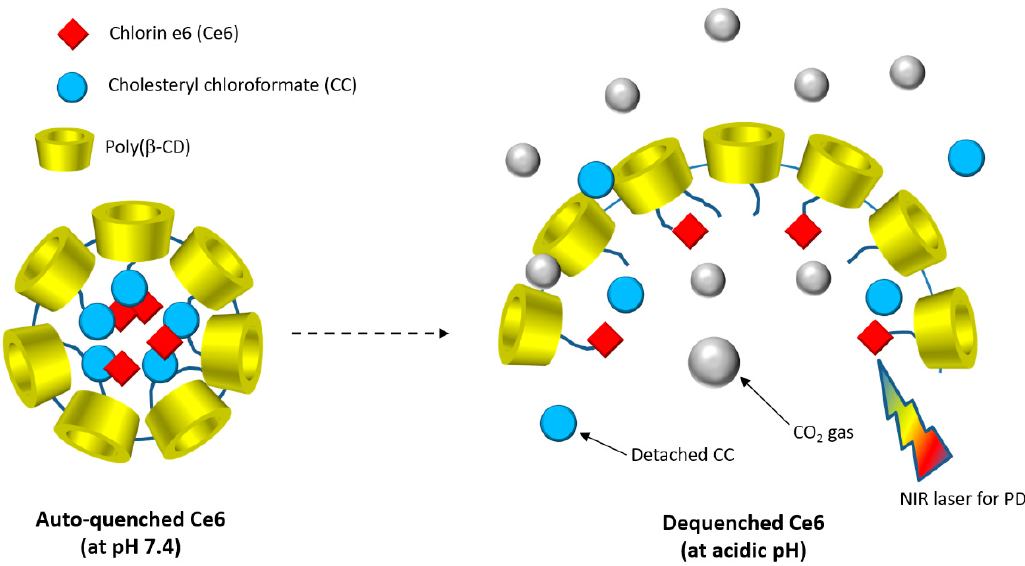
Figure 47. Schematic concept of the poly( β -CD)- g -CC- g -Ce6 NPs responding to an acidic pH.